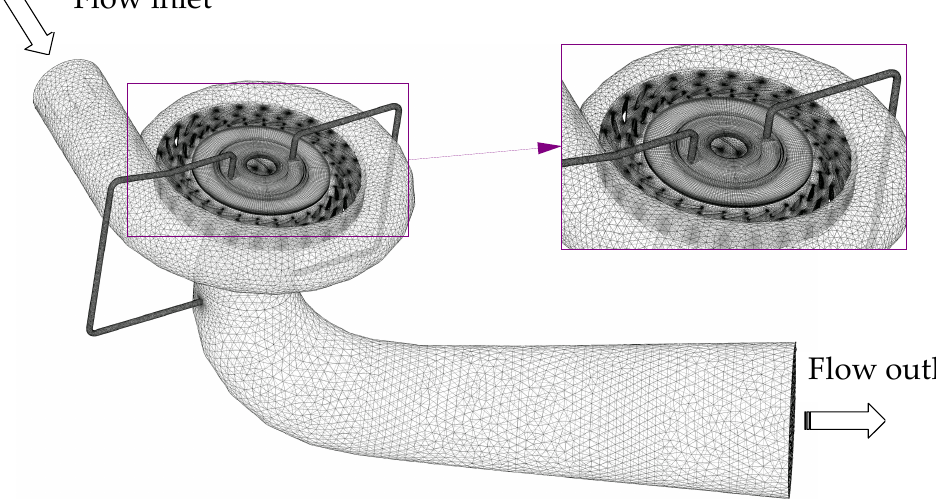
Figure 6. The finite volume mesh of the fluid domains for 3D CFD